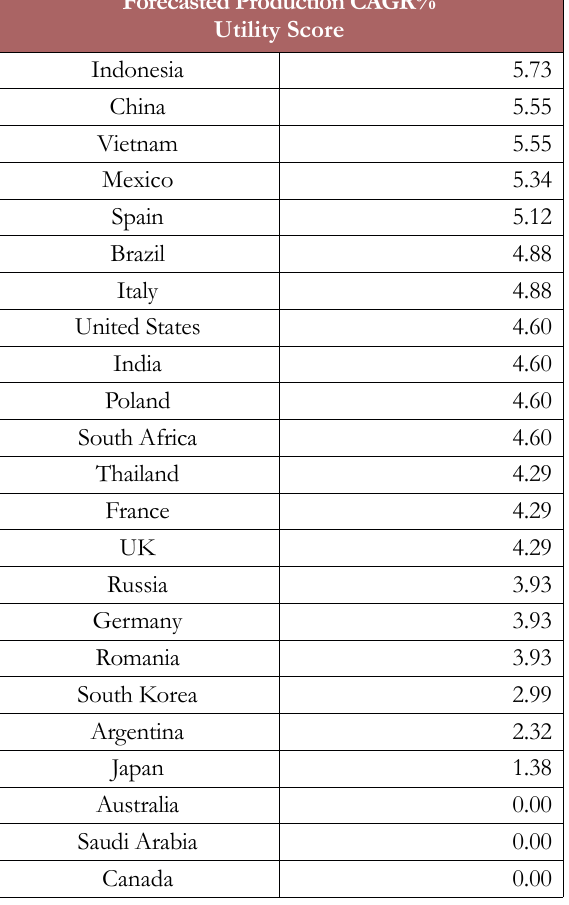
Table 9. Forecasted compound annual growth rate